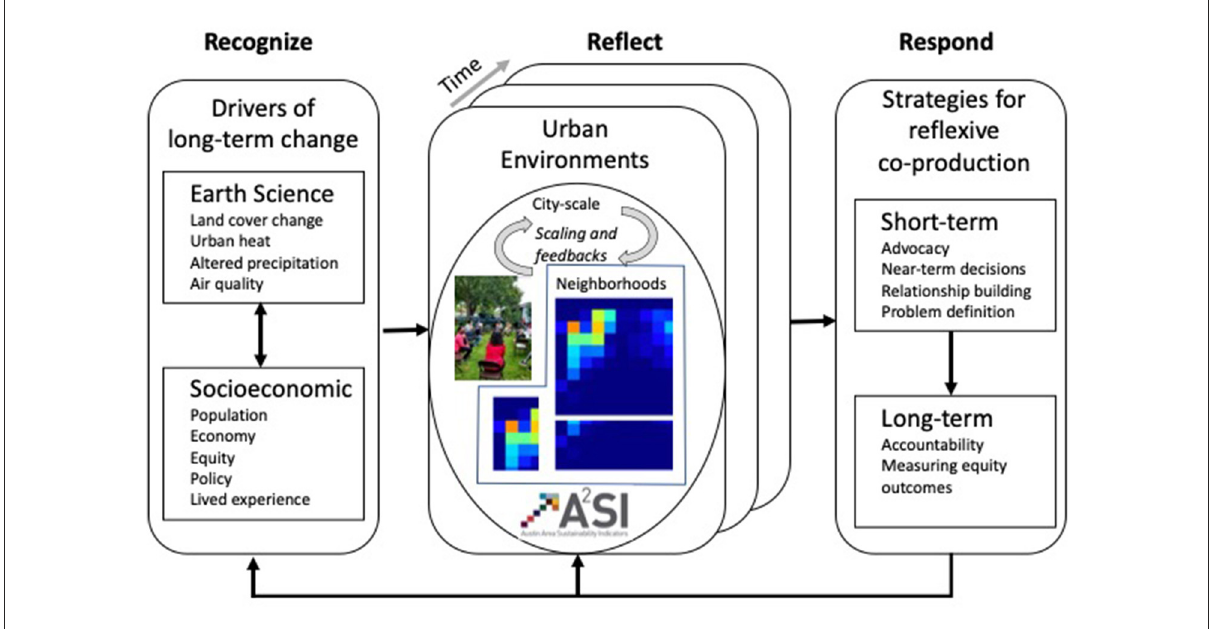
FIGURE2 Reflexive co-production activities for Urban